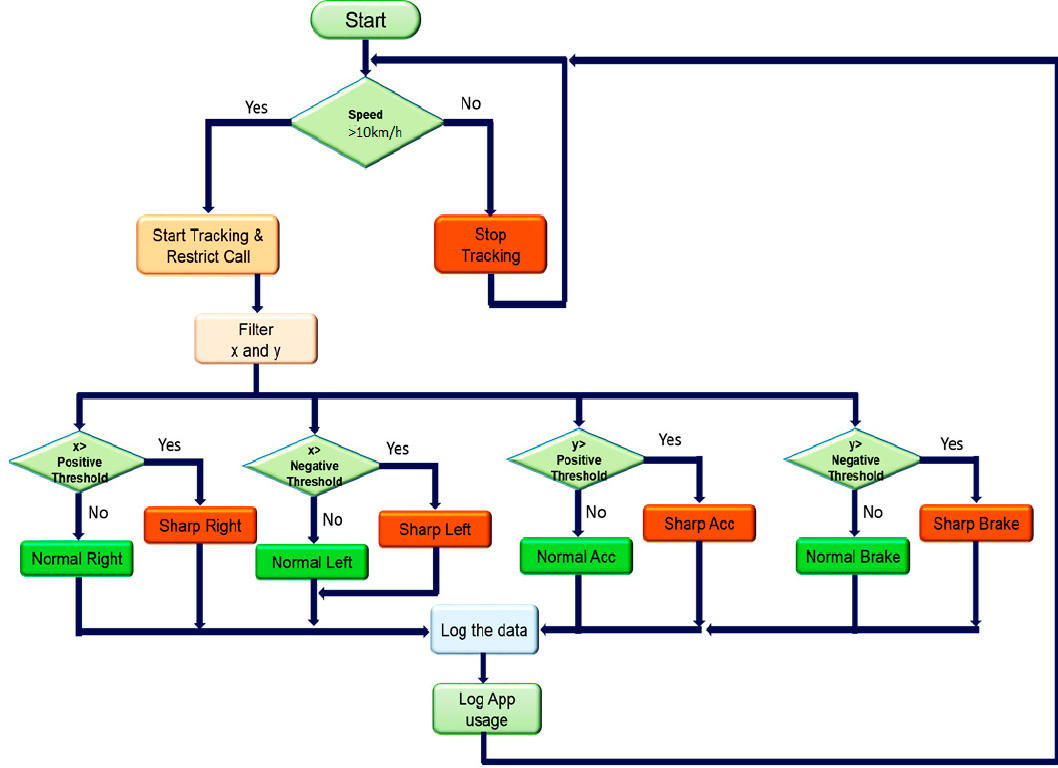
Figure 11. Flowchart of the mobile application’s decision stages.